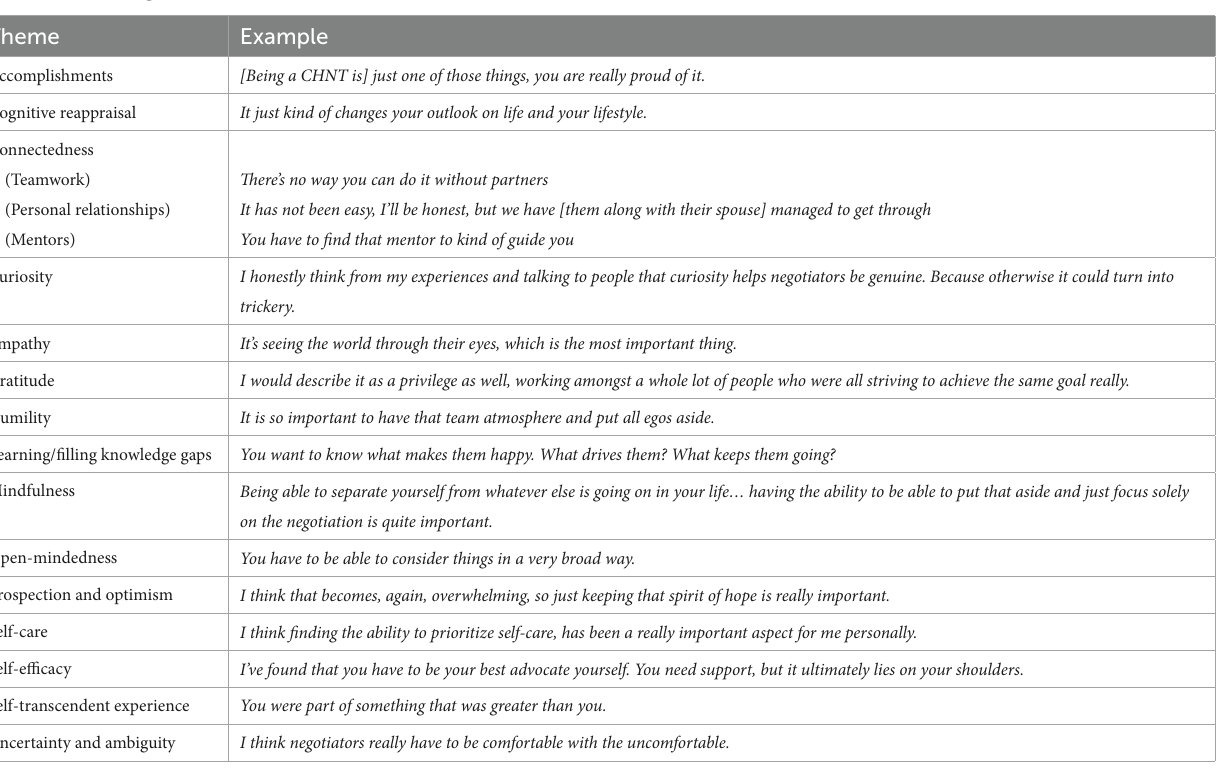
TABLE 2 Awe and negotiator-related